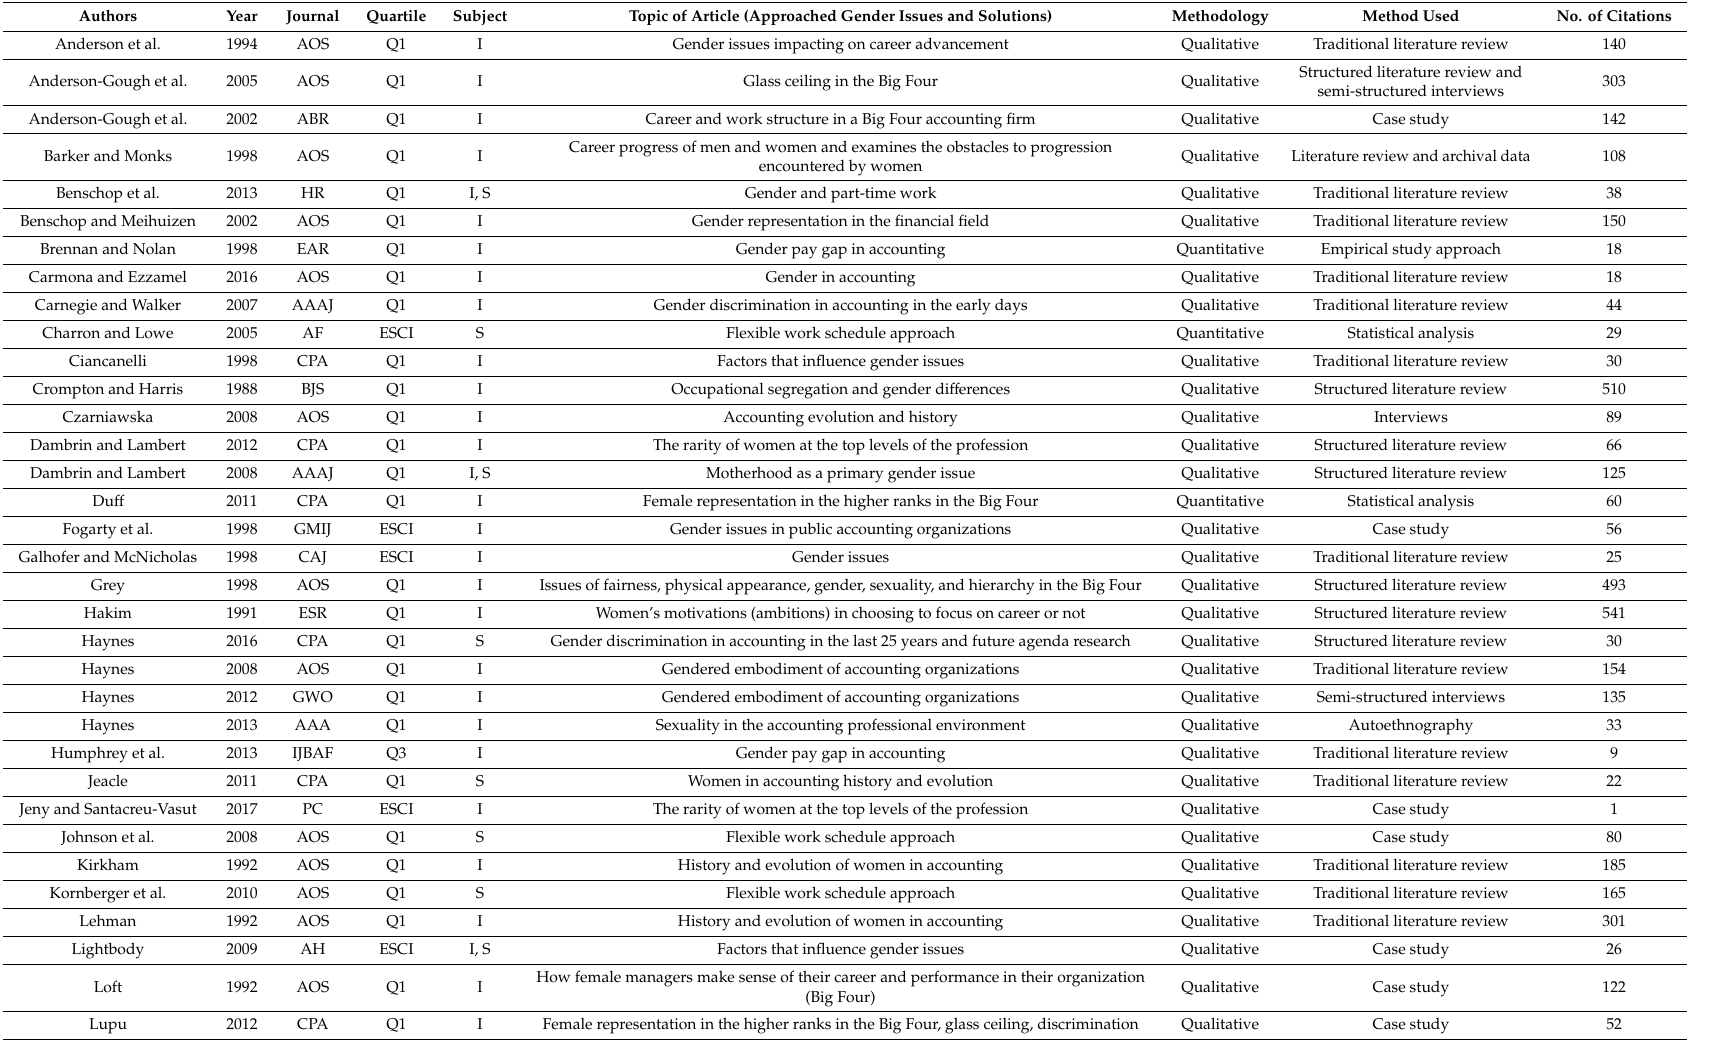
Table 1. The core articles used for the